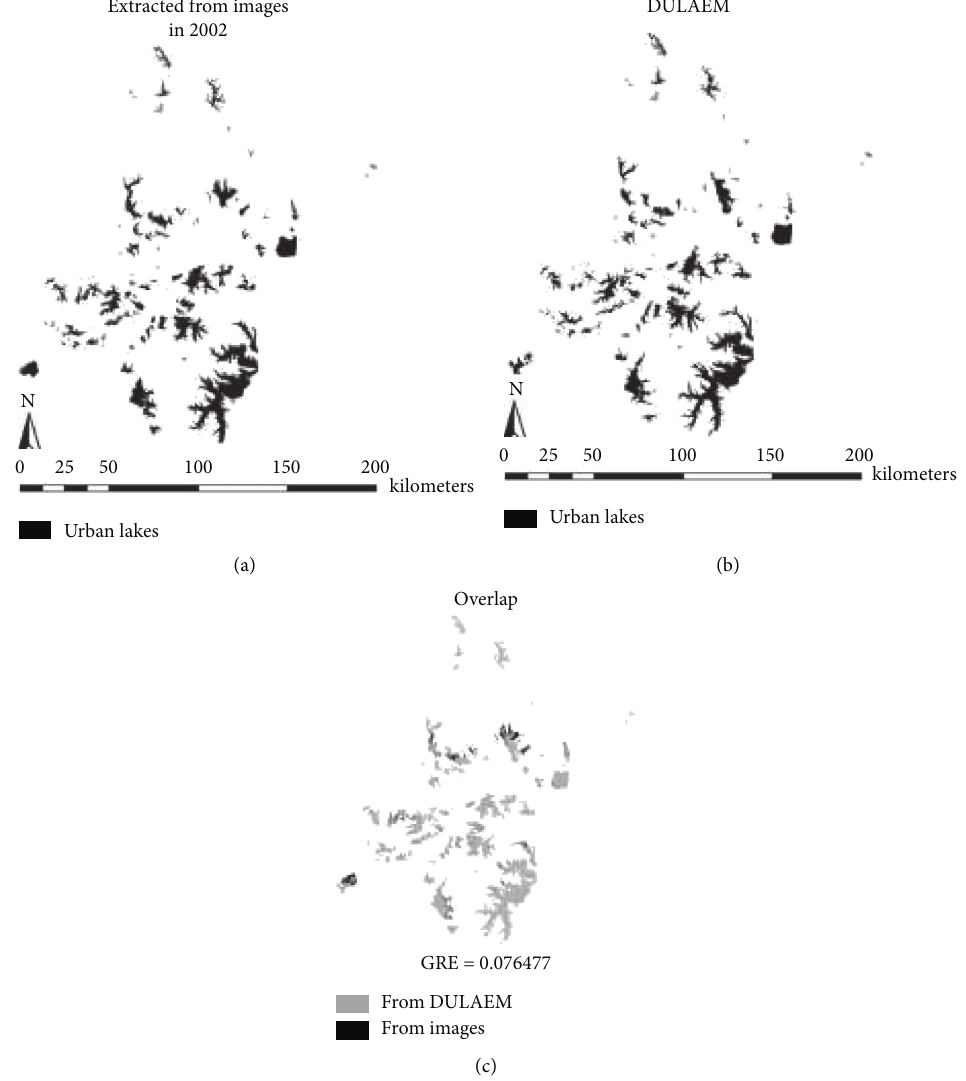
Figure 19: (a) Urban lakes extracted from Landsat images in 2002. (b) Urban lakes evolved by DULAEM. (c) Overlap of urban lakes in (a) with those in (b).